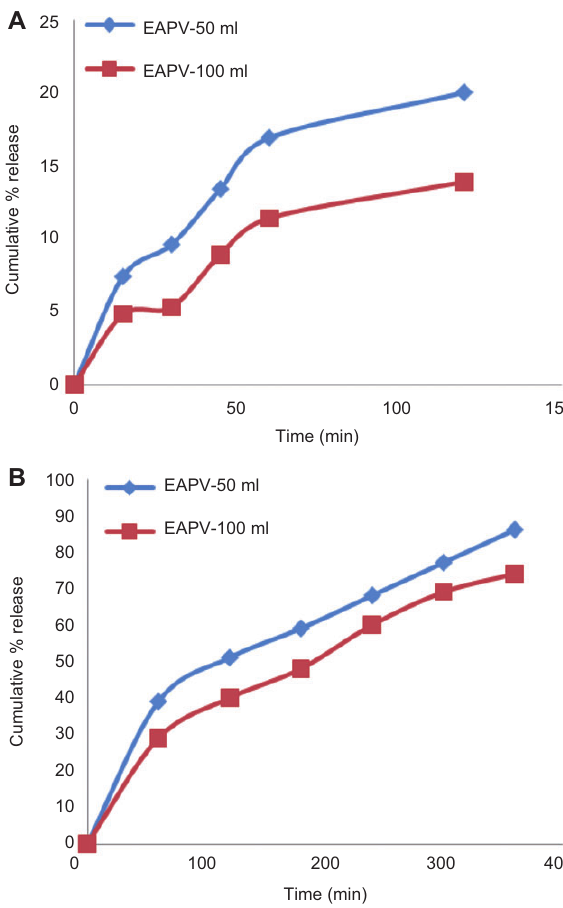
Figure 5 Release profiles of aspirin-loaded ethyl cellulose micro- particles: variation of external phase volume (A) in pH 1.2 acid solu- tions and (B) in pH 7.4 PB